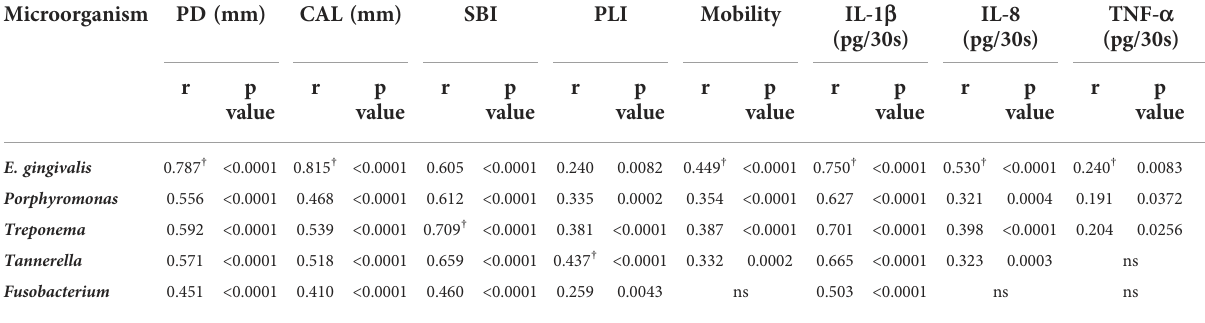
TABLE 3 Spearman correlation test between the relative abundance of microorganisms and periodontal parameters, as well as cytokines in gingival crevicular fl uid (GCF).